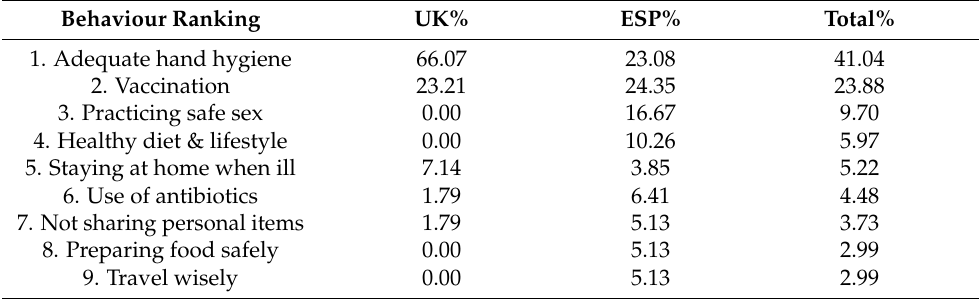
Table 5. Place in order of importance, the following practices in preventing the spread of infection. Behaviour Ranking UK%